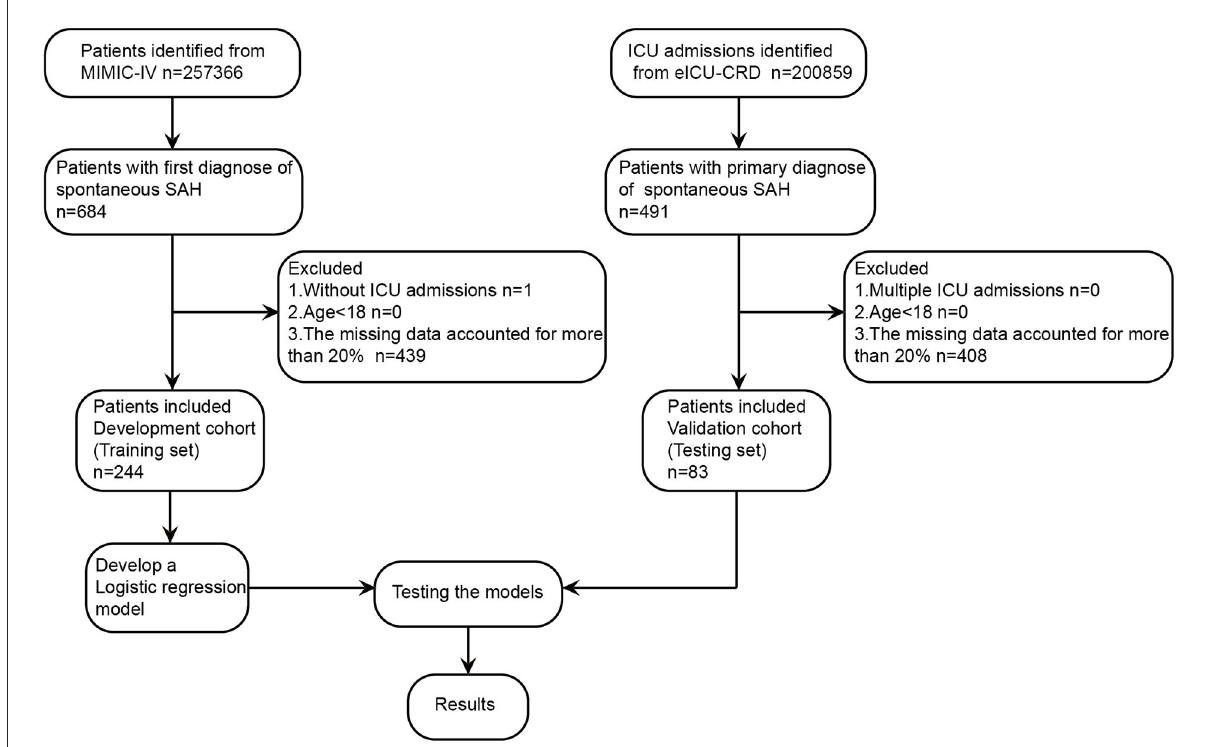
FIGURE1 Study design and study flowchart. eICU-CRD, eICU Collaborative Research Database; ICU, intensive care unit; MIMIC-IV, Medical Information Mart for Intensive Care-IV; SAH, subarachnoid hemorrhage.